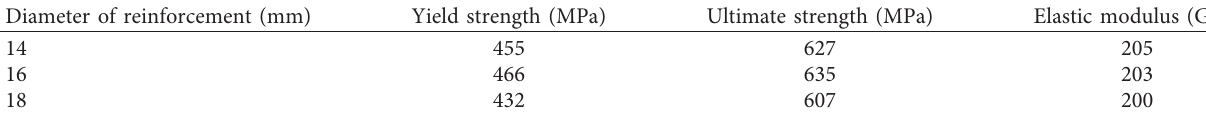
Table 4: Mechanical properties of stressed